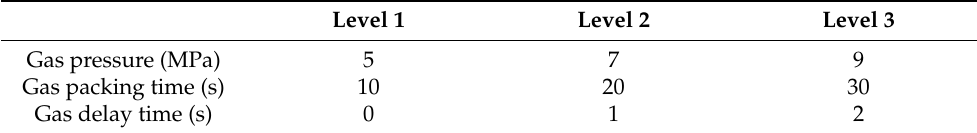
Table 2. Gas parameters and